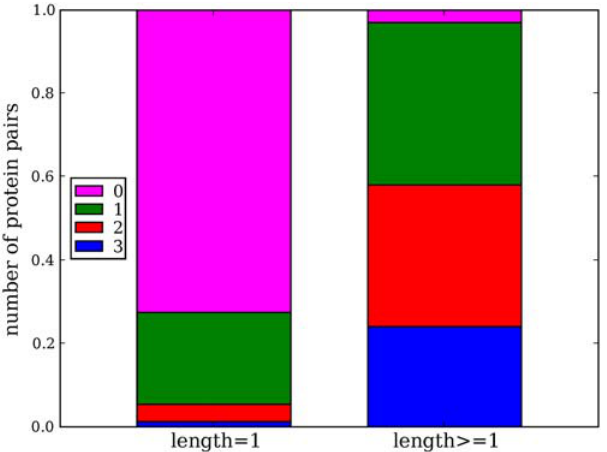
Figure 3. Prediction of CCPPs does not require the availability of data in all three networks. In the figure, we examine the set of 7510 correctly predicted interactions before the 50th false positive for an SVM trained using all three diffusion kernels. The figure plots the percentage of correctly predicted protein pairs that are directly linked (‘‘length=1’’) or linked by a path of any length (length $ 1) in three, two, one or none of the three interaction networks.